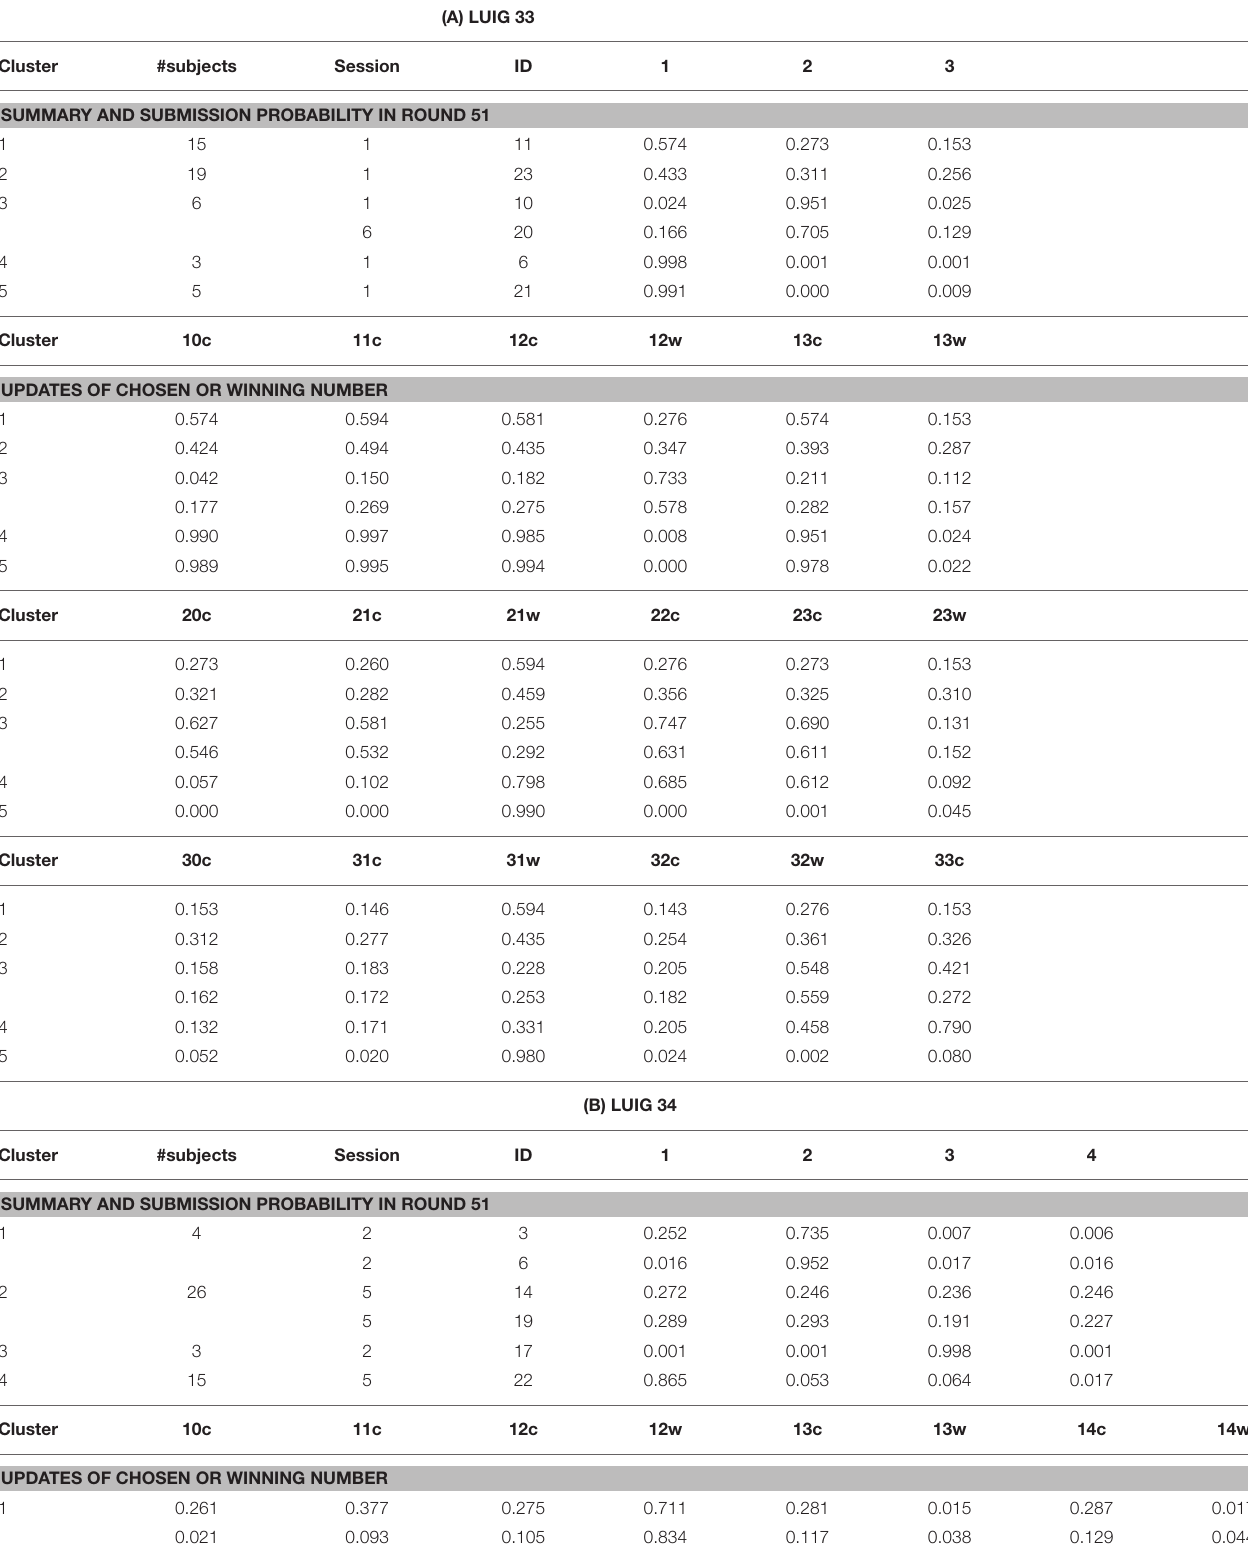
TABLE 2 | Expected behaviors of representative agents in each cluster (ID: Subject ID in the